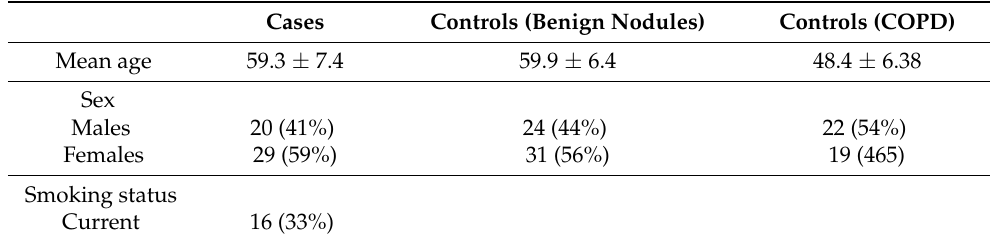
Table 1. Basic subject characteristics among cases and